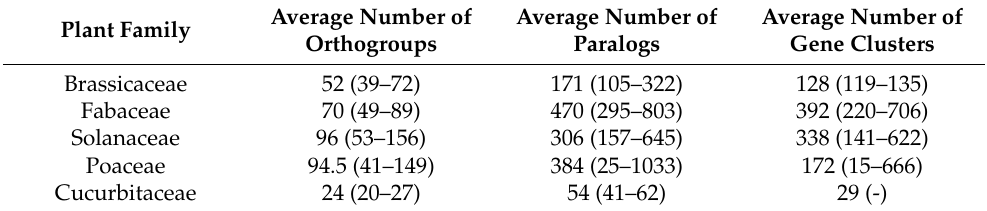
Table 1. Number of orthogroups, paralogs and gene clusters in five principal crop families.